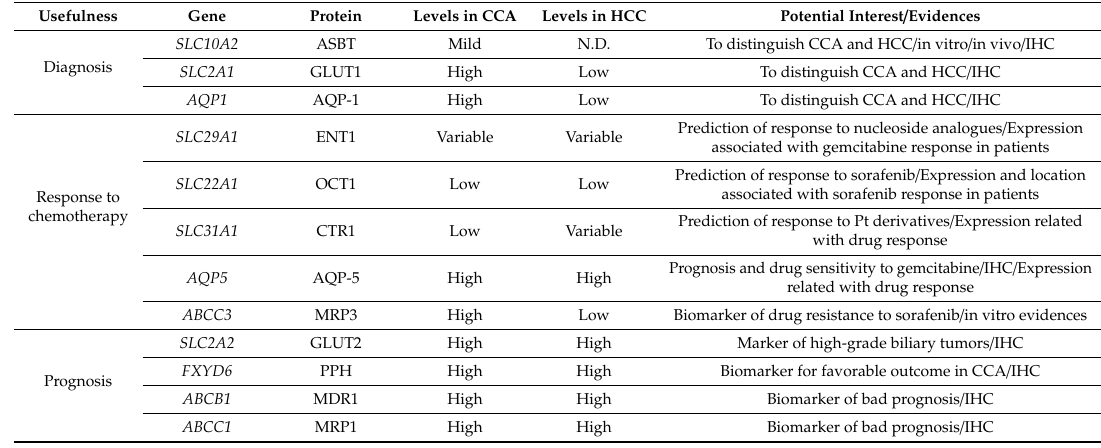
Table 1. Plasma membrane transporters with potential usefulness as